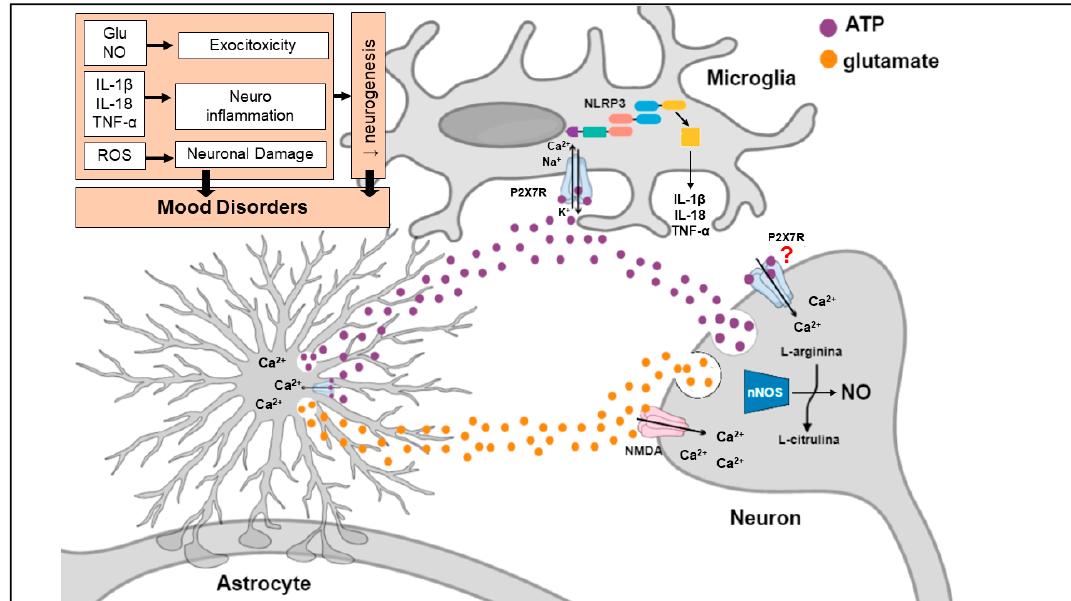
Figure 4. P2X7 receptor involvement in mood disorders. Stress exposure elicits a massive ATP and glutamate release with consequent activation of P2X7R and NMDA receptors, respectively. Stimulation of these receptors leads to: 1. enhanced K + efflux resulting in NLRP3 inflammasome activation and secretion of inflammatory cytokines (e.g., IL-1 β , IL-18, TNF- α ) from astrocytes and microglia; 2. increased Ca 2+ influx leading to ATP and glutamate release from nerve terminals and astrocytes, which is responsible to excitotoxicity; 3. NMDA-mediated nNOS activation and consequent NO formation in nerve terminals, also contributing to excitotoxicity process; 4. ROS production causing neuronal damage. Under conditions of stress, high levels of ATP, glutamate and pro-inflammatory cytokines are maintained by a regenerative circuit, even after stress stimulus termination, which leads to diminished BDNF levels, decreased synapto-/neuro-genesis and damage of brain circuits important for emotional/mood regulation. Further investigation is required to better elucidate whether P2X7R induce glutamate and ATP release by its direct action in neurons or due the indirect activation of these receptors in glial cells. ATP: adenosine triphosphate; Ca 2+ : calcium; IL-18: interleukin-18; IL-1 β : interleukin-1 β ; K + : potassium; Na + : sodium; NMDA: N-methyl-D-aspartate receptor; nNOS: neuronal nitric oxide synthase; NO: nitric oxide, ROS: reactive oxygen species; TNF- α : tumor necrosis factor alpha.